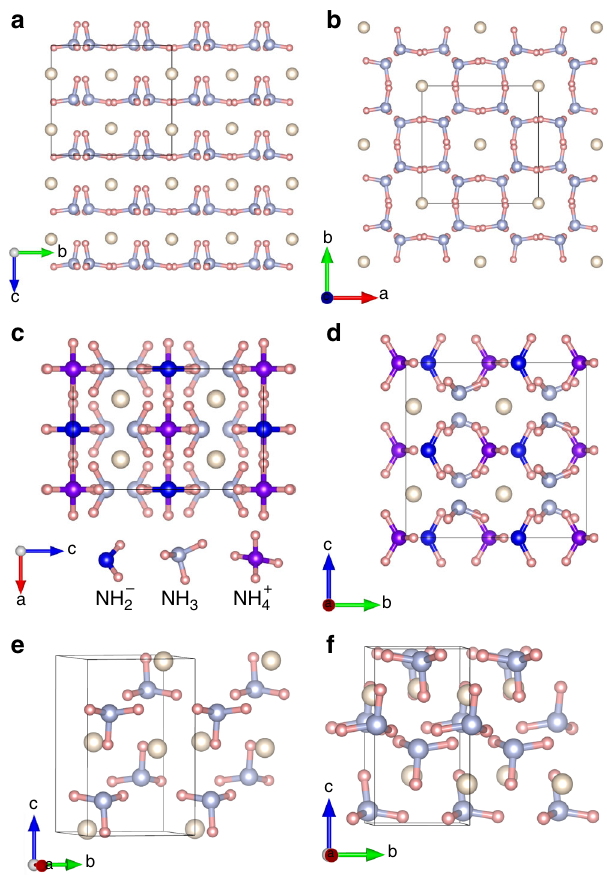
Fig. 3 Structural con fi gurations. a , b The I 4 structure of (NH 3 ) 2 He at 10 GPa along the a -axis and c -axis, respectively. c , d The Fmm 2 structure of (NH 3 ) 2 He at 180 GPa in the direction of b -axis and a -axis, respectively. e The Pnma structure of NH 3 He at 30 GPa, and f the P 2 1 2 1 2 1 structure of NH 3 He at 180 GPa. The light blue, pink, and cream-colored atoms represent N, H, and He, respectively. Blue, light blue, and purple spheres in c , d are used to distinguish the N atoms in ð NH 2 Þ (cid:2) , NH 3 , and ð NH 4 Þ þ , respectively.